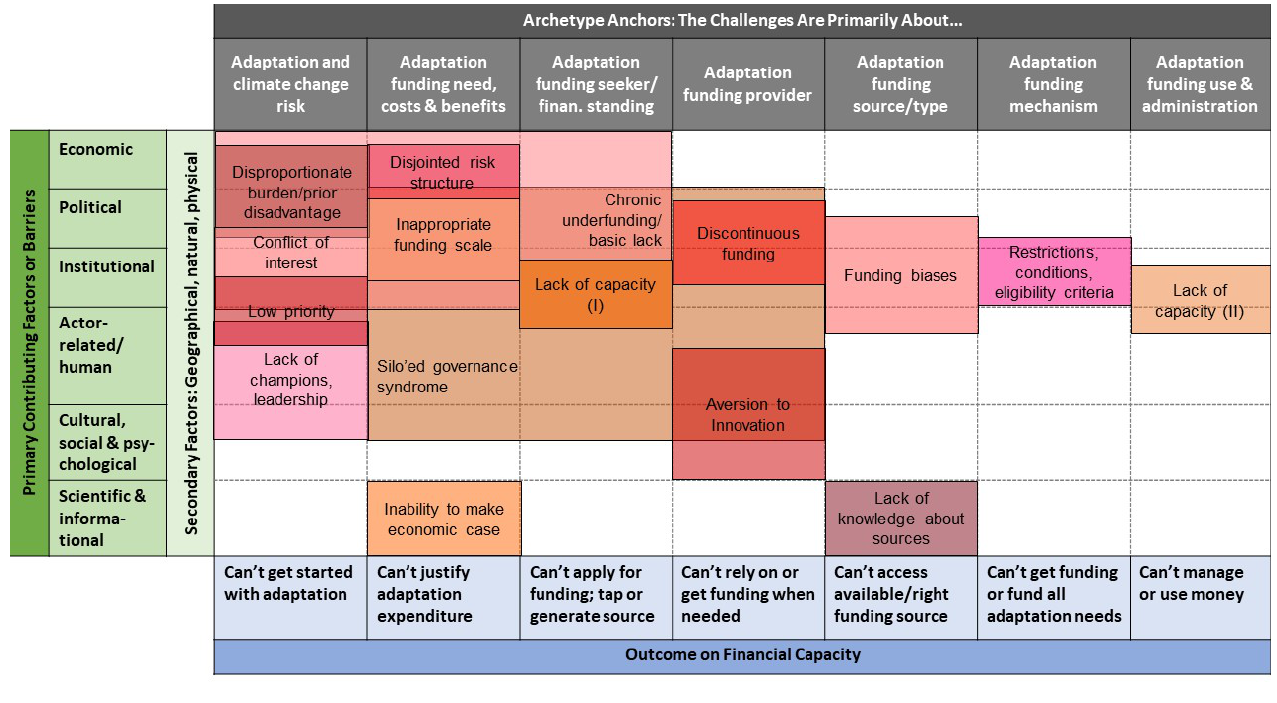
Fig. 2 . The landscape of adaptation finance archetypes circumscribed by underlying contributing factors, focal points, and immediate funding-related